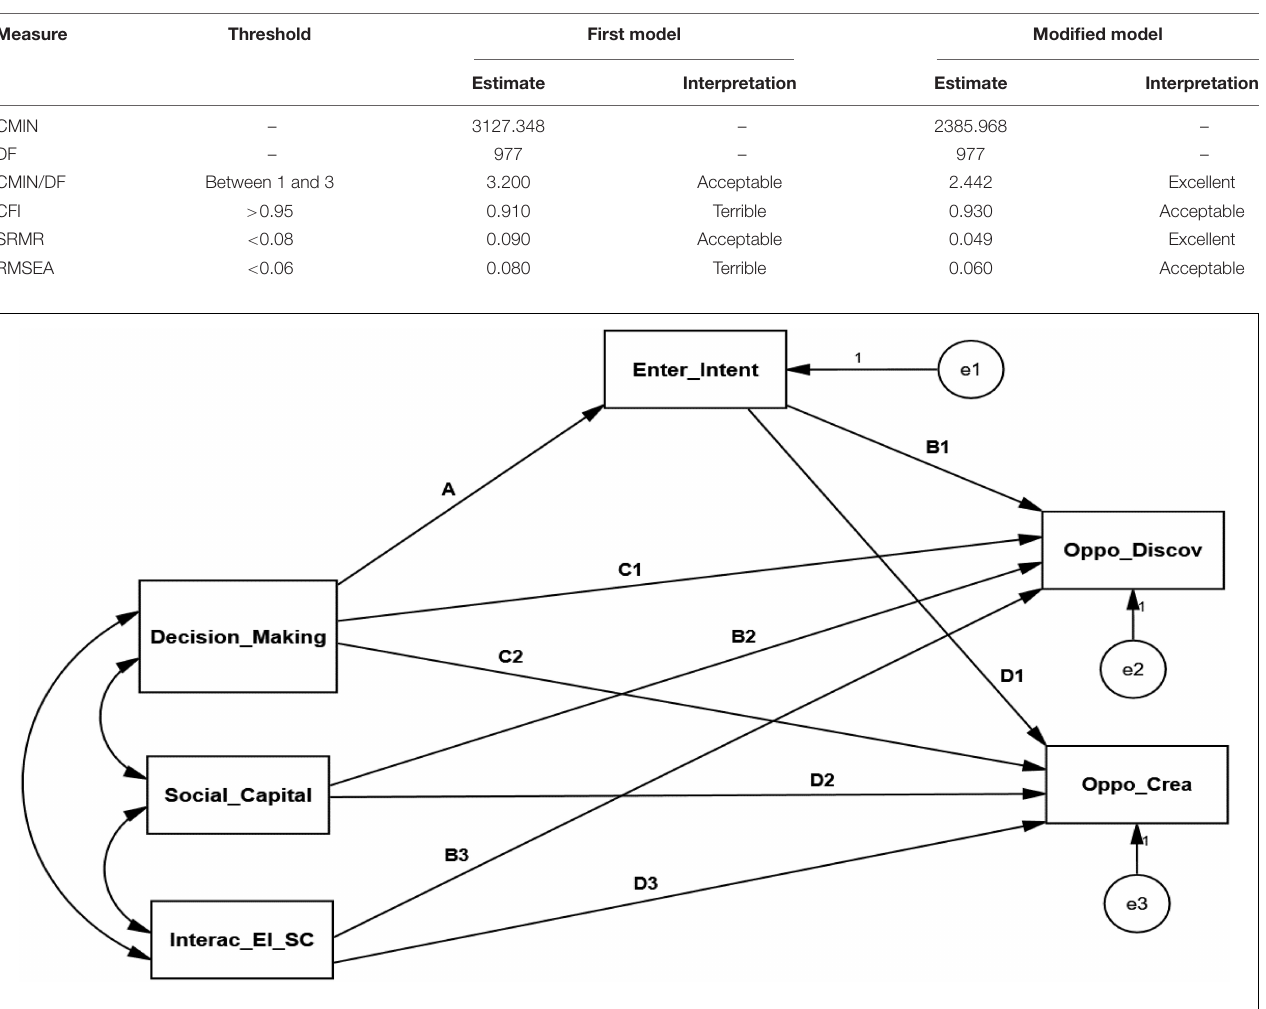
FIGURE 2 | Structural model